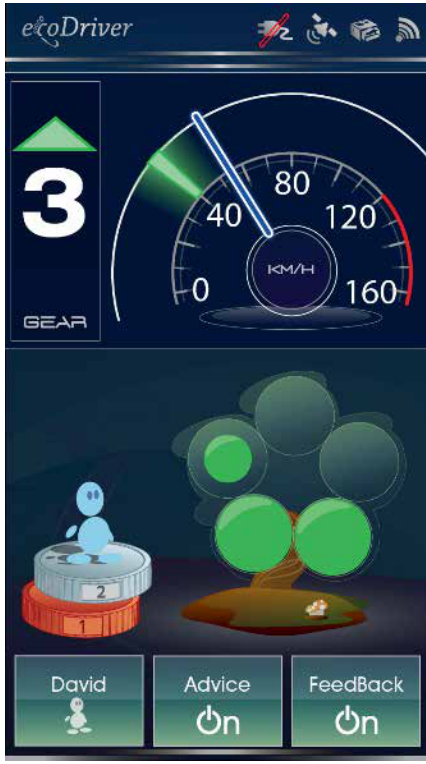
Figure 1: Main screen of the Full ecoDriver System